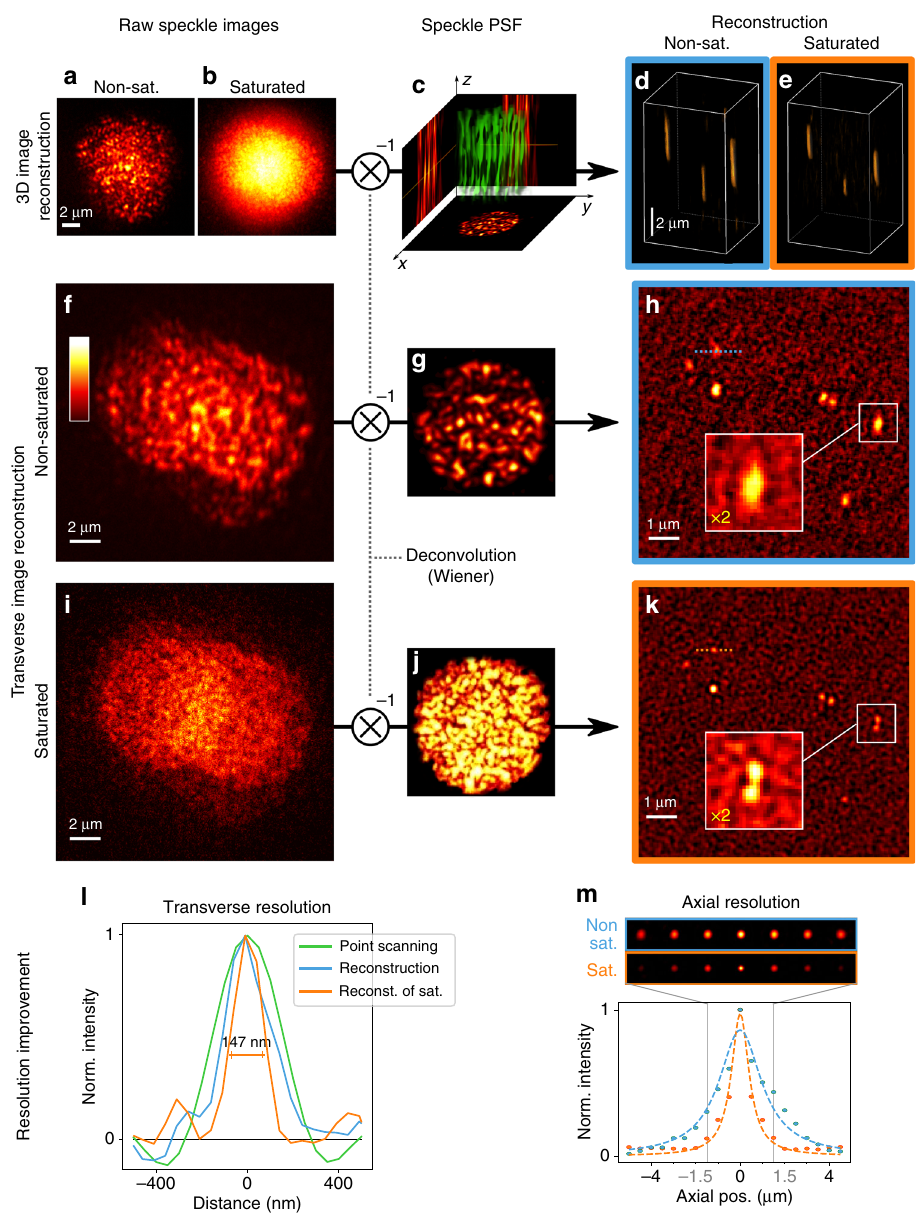
Fig. 2 3D super-resolution capabilities. 2D-scanning of fl uorescent nano-beads by speckles ( a , b ) allows 3D object reconstruction ( d , e ). Image reconstruction is achieved by plane-by-plane Wiener deconvolution thanks to the prior experimental characterization of the 3D-SPSF ( c ). Speckle images were taken under non-saturated ( a , f ) and saturated ( b , i ) conditions. By depositing fl uorescent 100 nm-beads on a coverslip, a bead cluster could be observed to be only resolved under saturated conditions ( k ) and not by linear-excitation speckle imaging ( h ). Line pro fi les in ( h , k ) are plotted in ( l ) and compared to the pro fi le obtained by deconvolved point-scanning imaging (Supplementary Fig. 12). Resolution is improved in the speckle imaging mode as compared to point-scanning mode and super-resolution is obtained under saturated excitation conditions. Axial resolution improvement is shown in m where an axial bead intensity pro fi le is plotted both in the linear and in the saturated excitation regimes. In all images, NA = 0.77 and saturated images were recorded with an average saturation parameter 〈 s 〉 =